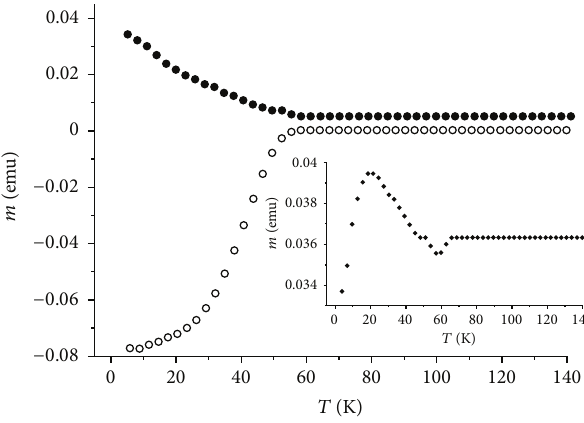
Figure 9: FC magnetizations as a function of temperature of freshly prepared YBa 2 Cu 3 O 6+𝛿 sample (empty points) and of hydrated sam- ple (black points) at 𝐻 = 500 Oe. Inset: the temperature dependence of magnetization of hydrated sample at 𝐻 = 10